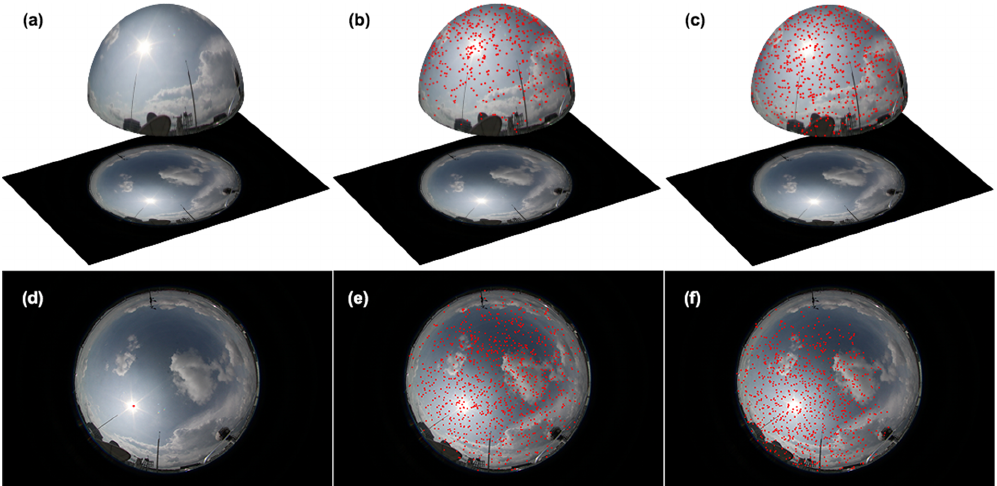
Figure 6. Cosine-weighted hemispheric sampling process. We plot the following: (a) a projection of the original image on a hemisphere, (b) cosine hemispheric sampling with the origin at the top, (c) a rotation matrix applied to the center at the sun location, (d) the original image with the detected sun location in red, (e) a projection of the sampled points onto the image, and (f) a projection of the rotated sampled points onto the image.